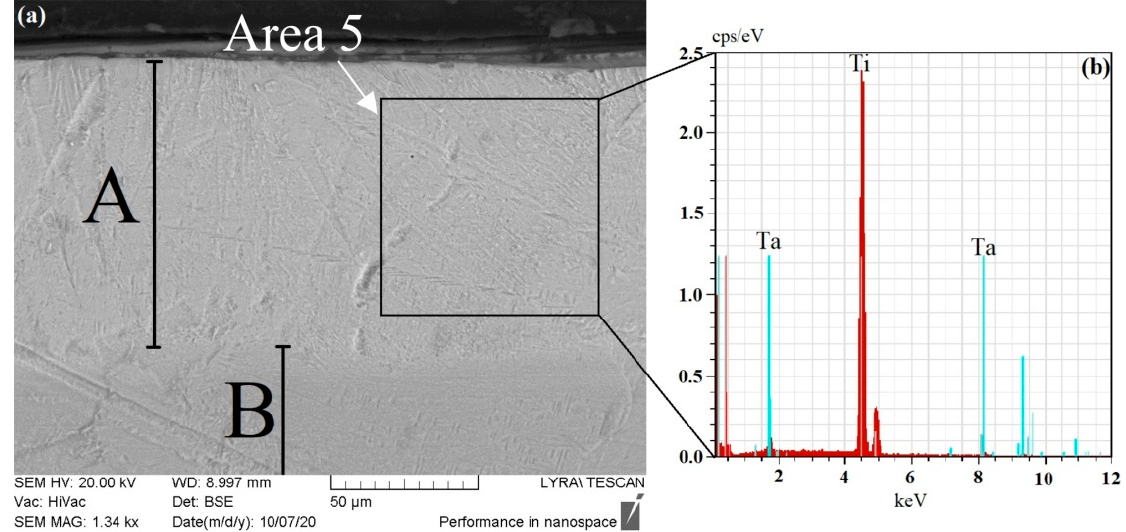
Figure 4. A cross-sectional SEM image of the sample processed with a beam power of 1750 W ( a ) and corresponding EDX spectrum taken from the alloyed zone ( b ).